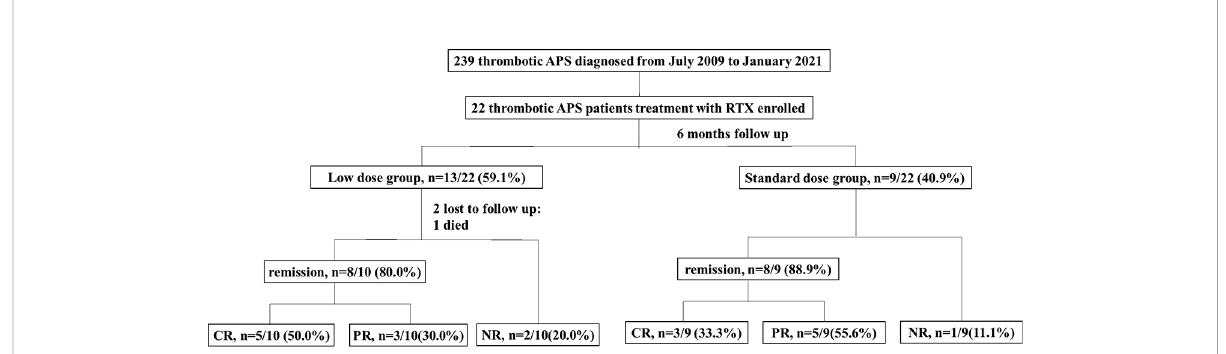
FIGURE 1 Flow chart of the patients with isolated thrombotic APS receiving rituximab therapy. There were 22 patients enrolled, with 13 patients received low dose rituximab (an overall dosage <1000mg) and 9 patients received standard dose rituximab (an overall dosage ≥ 1000mg). One patient discontinued treatment because of died, 2 patients lost to follow up, and 19 patients complement within 6-month follow up. The remission rate was 80.0% (50.0% CR, 30.0%PR) in the low dose group and 88.9% (33.3% % CR, 55.6%PR) in the standard dose group. CR, complete remission; PR, partial remission; NR, no remission.